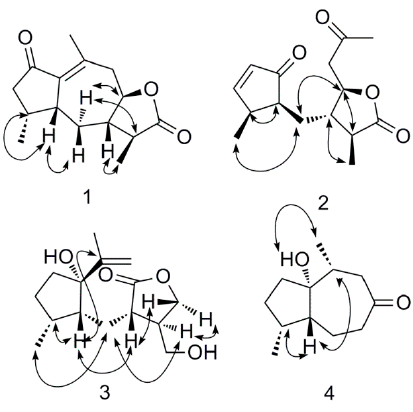
Figure 3. Key NOESY correlations of compounds 1 – 4 .